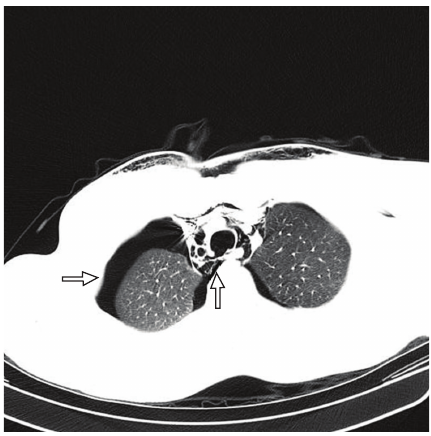
Figure 1: CT chest image depicting tear in the posterior part of the trachea with a right-sided pneumothorax.